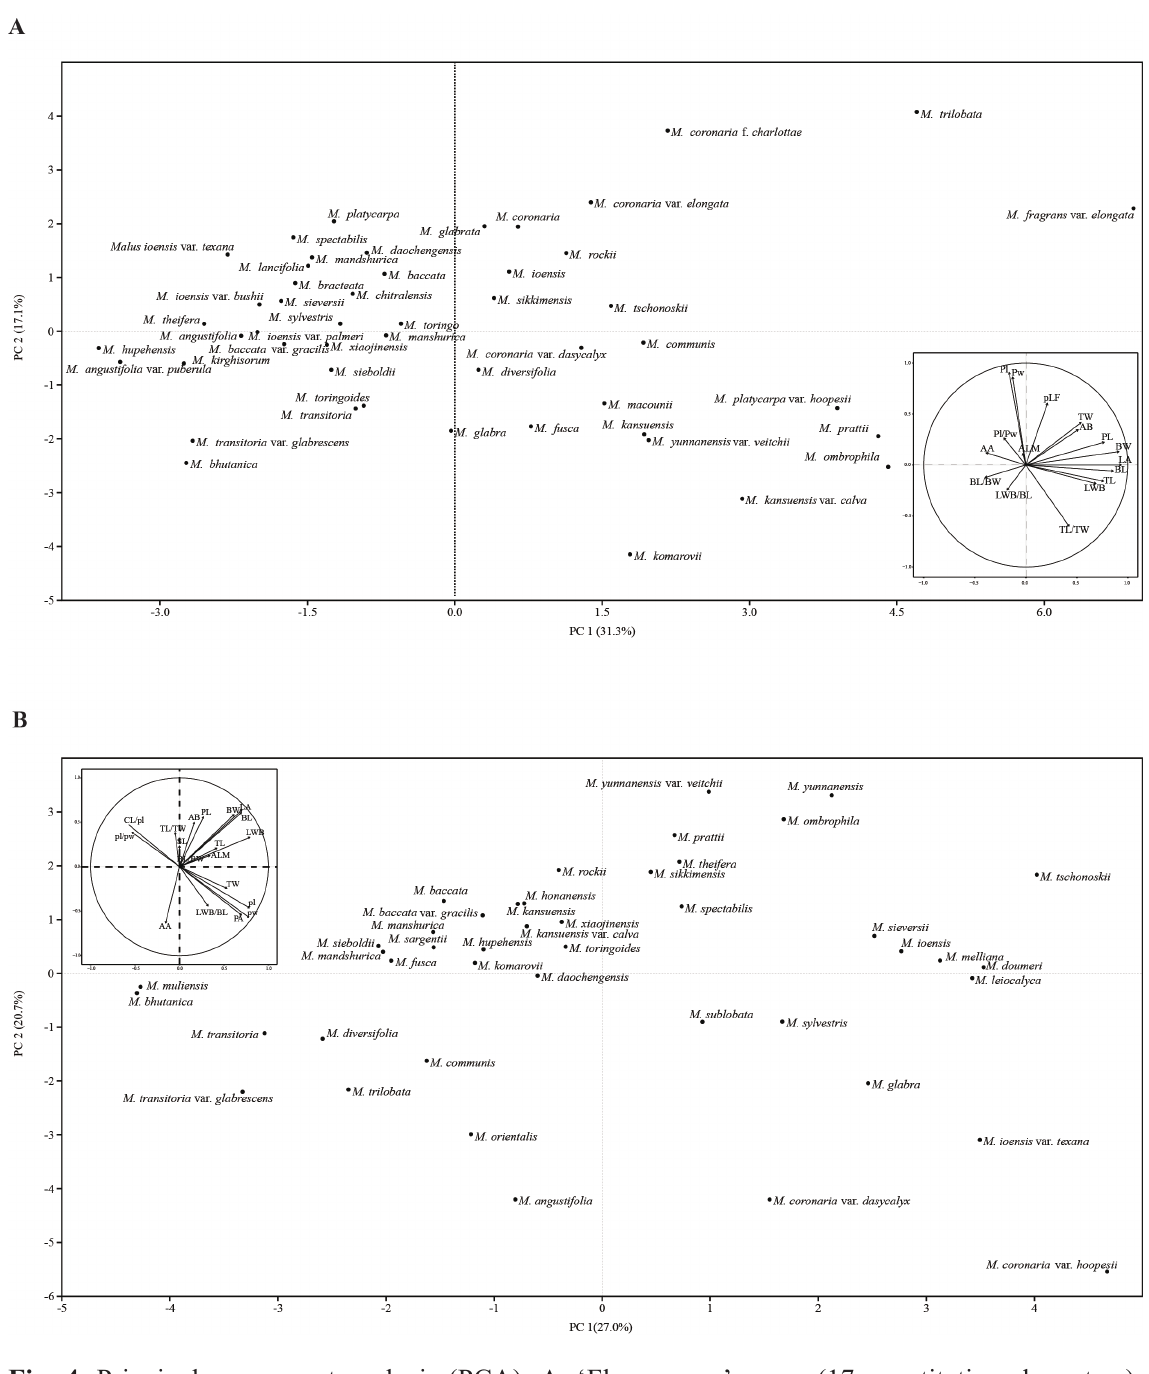
Fig. 4. Principal component analysis (PCA). A . ‘Florescence’ group (17 quantitative characters). B . ‘Fruiting season’ group (19 quantitative